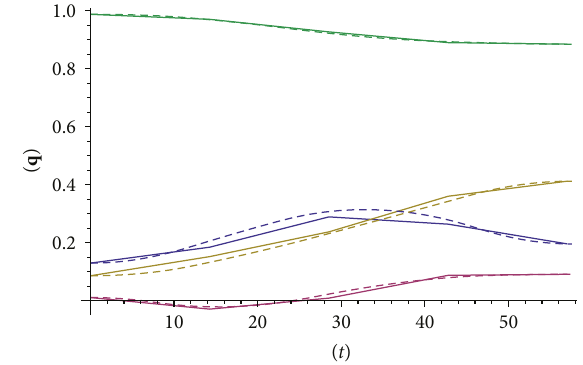
Figure 9: Attitude parameters of a minimum-time rest-to-rest maneuver of the spacecraft between the target attitudes q given in Table 1. The solution obtained with the fi fth-degree Gauss- Lobatto direct collocation method is represented with continuous lines whereas the solution obtained with the pseudospectral method is represented with dashed lines.